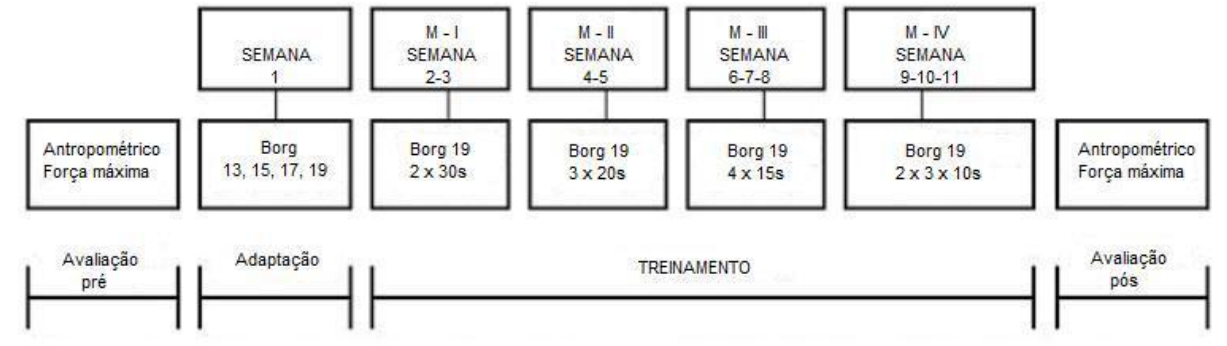
Figura 1. Modelo experimental do estudo, semanas de 1 a 11, com avaliações pré e pós-treinamento (antropométrico e de força máxima dinâmica), período de adaptação e mesociclos de treinamento (M-I a M-